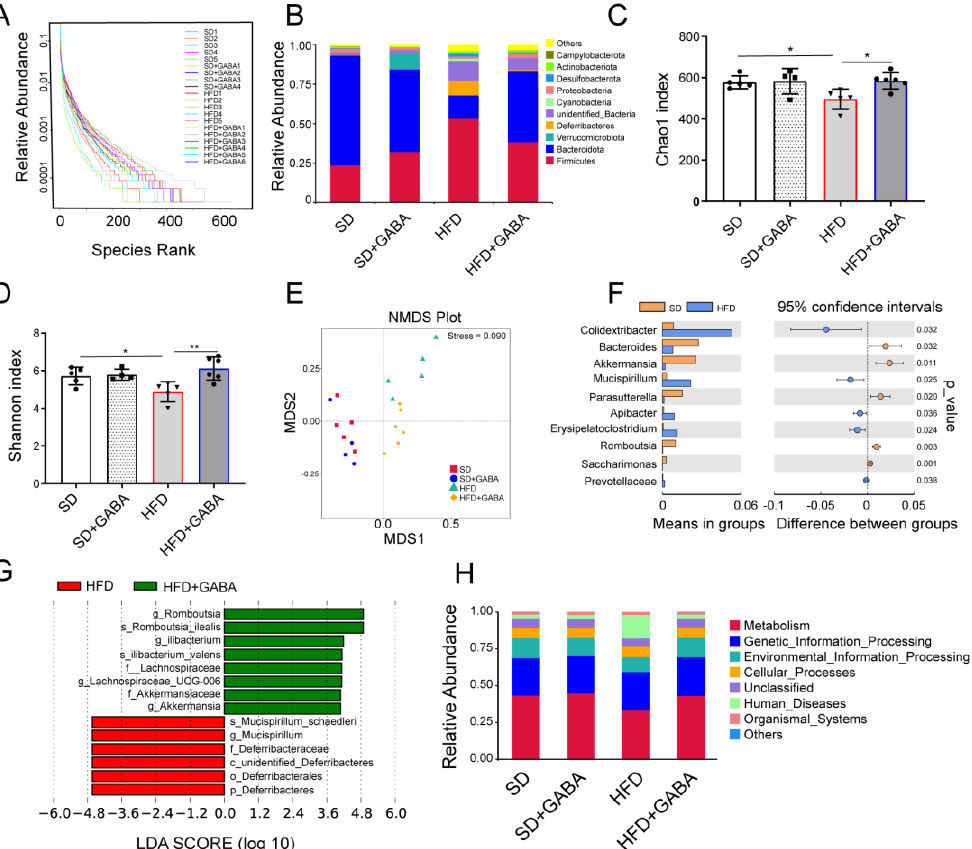
Figure 4. GABA modulates the composition of gut microbiota. ( A ) Relative abundance of intestinal flora in the four experimental groups. ( B ) Phylum level analyses were based on OTU classification; “others” indicates OTUs that were not classified at the phylum level. ( C , D ) Gut microbiota richness, as indicated by the Chao1 and Shannon indices. ( E ) NMDS plots for metabolomics analysis (Stress = 0.09). ( F ) The t -test of differential species abundance under each level between the SD group and HFD group. ( G ) Comparison of microbial variations, using LEfSe (LDA Effect Size) analysis, between the HFD and HFD+GABA groups. ( H ) Relative abundance of Tax4Fun function annotations. LEfSe, linear discriminant analysis effect size. n = 4–6 for all groups. OTU, operational taxonomic unit. * p < 0.05 and ** p < 0.01.